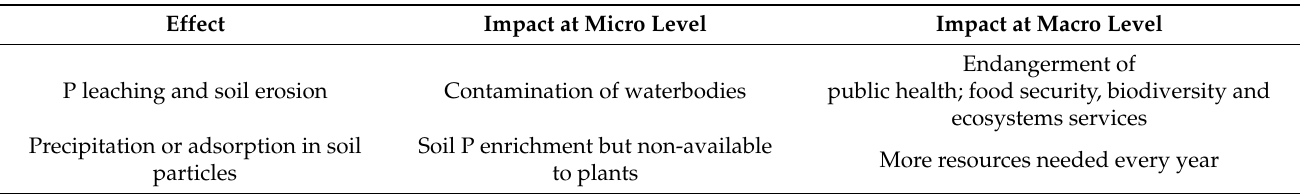
Table 1. Micro- and macro-effects of traditional phosphorus